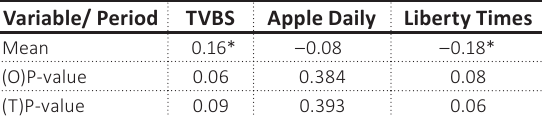
Table 7. Two alternative testing methods for CAR of the initial polls